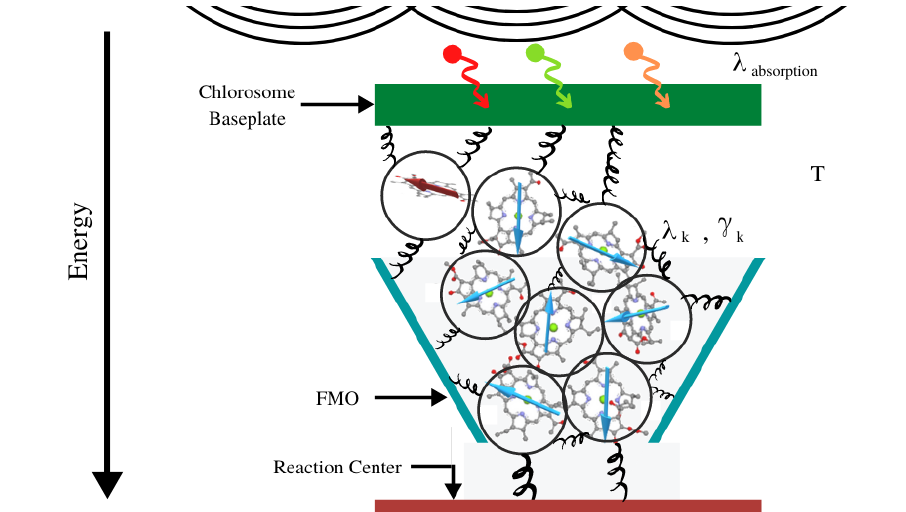
Figure 2. Schematic representation of excitation energy transfer conditions and interactions in